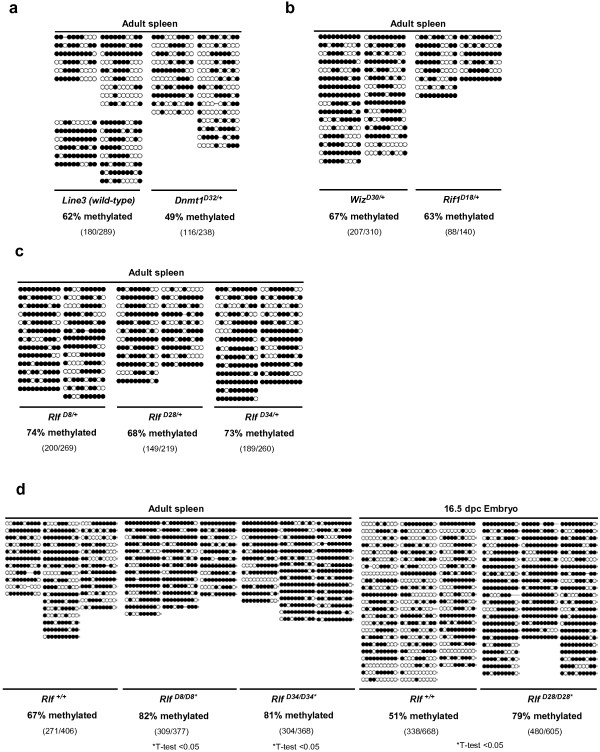
Bisulfite sequencing of the HS-40 enhancer region of the GFP transgene. (a) DNA methylation levels were reduced in Dnmt1MommeD32 heterozygous mice compared to wild-type mice in adult spleens (n = 4 wild-type mice and n = 2 Dnmt1MommeD32 mutant mice). Filled circles represent methylated CpG sites. (b) DNA methylation levels in adult spleens were unaffected in mice heterozygous for WizMommeD30 and RifMommeD18 (n = 4 for WizMommeD30 and n = 2 for Rif1MommeD18). (c) DNA methylation levels in adult spleens of RlfMommeD8, RlfMommeD28 and RlfMommeD34 heterozygotes were increased compared to wild-type mice (n = 2 mice for all genotypes). (d)Rlf homozygotes showed significantly increased DNA methylation (T-test, P < 0.05) in adult male spleen (RlfMommeD8 and RlfMommeD34) and 16.5 dpc embryo (RlfMommeD28) compared to wild types (n = 3 for all genotypes).